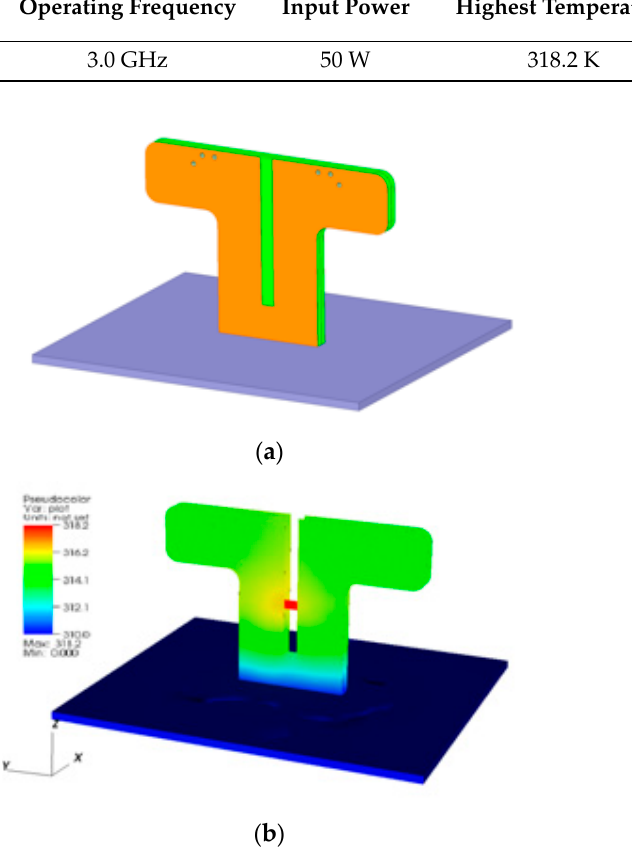
Figure 3. ( a ) Schematic view of antenna element and ( b ) calculated temperature